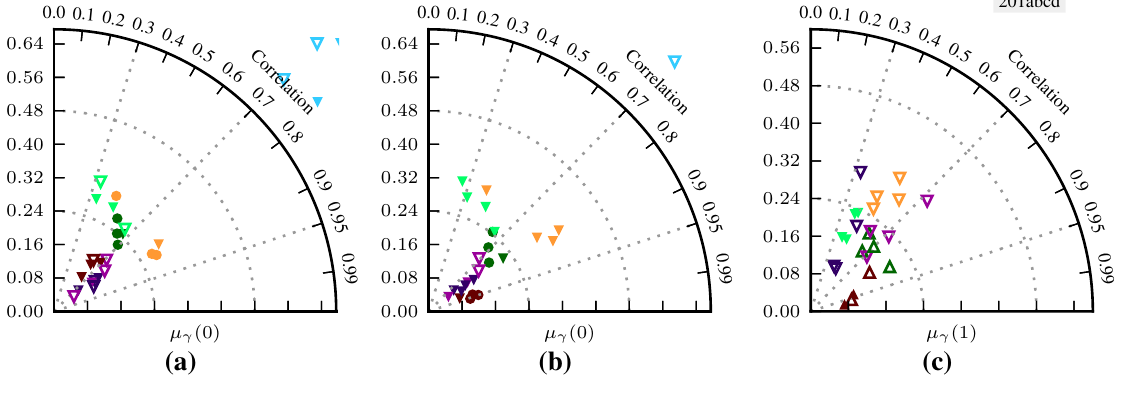
Figure 9. Taylor plots for the phase φ and the coherence γ at VV polarization; cf. Figure 6 for a description of these plots. ( a ) φ V V , ζ “ 0 , PEP; ( b ) φ V V , ζ “ 0 , HAL; ( c ) | γ V V | , ζ “ 0 ,